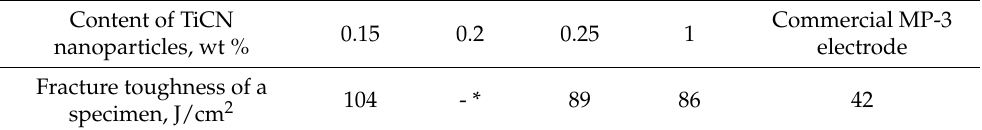
Table 3. Fracture toughness of samples with coatings deposited with electrodes modified by titanium carboniride additives of different content and commercial electrodes MP-3.